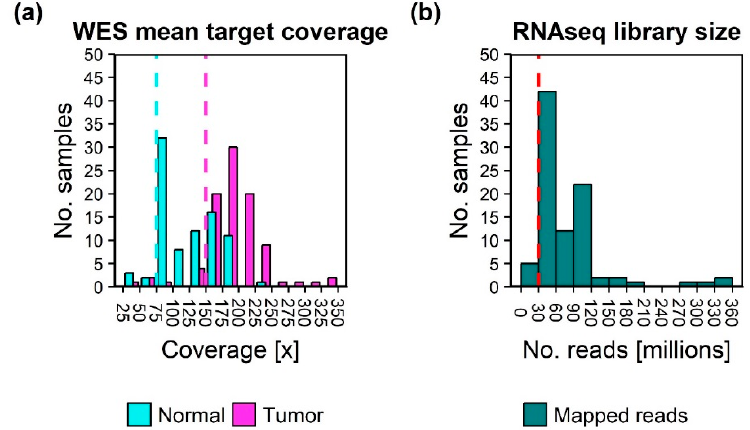
Figure 2. Histograms of sample sequencing depth. ( a ) Average target coverage of normal and tumor Whole Exome Sequencing (WES) samples. ( b ) Total mapped paired end RNAseq reads. Dashed lines indicate the minimum sample depth requirements.